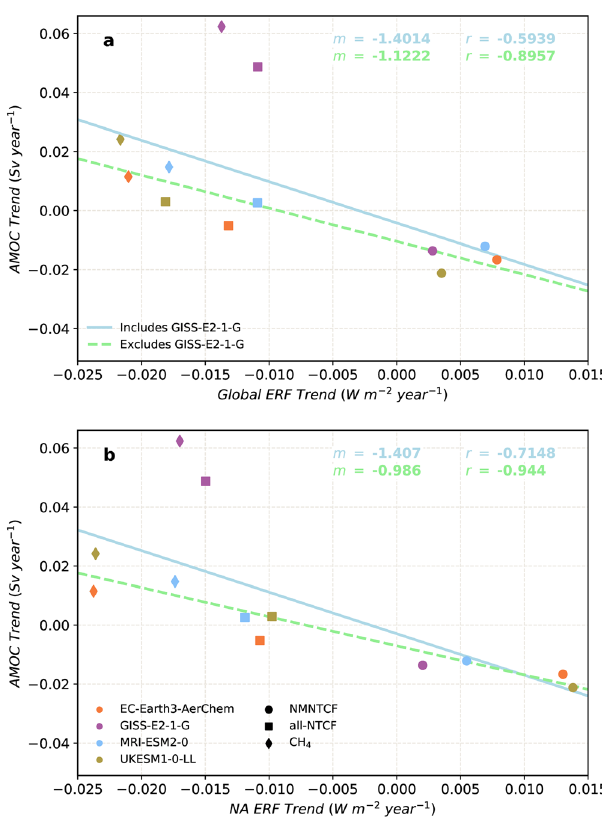
Fig. 4 AMOC versus effective radiative forcing trend scatter plot. AMOC trends [Sv year − 1 ] versus a global and b North Atlantic annual mean effective radiative forcing (ERF) trend [W m − 2 year − 1 ] for all models and mitigation signals. Also included is the slope of the least-squares trend line ( m ) and the correlation coef fi cient ( r ). Bold indicates signi fi cance at the 95% con fi dence level (all are signi fi cant). Light blue statistics and the trend line is for all models; light green statistics and the trend line is for all models without